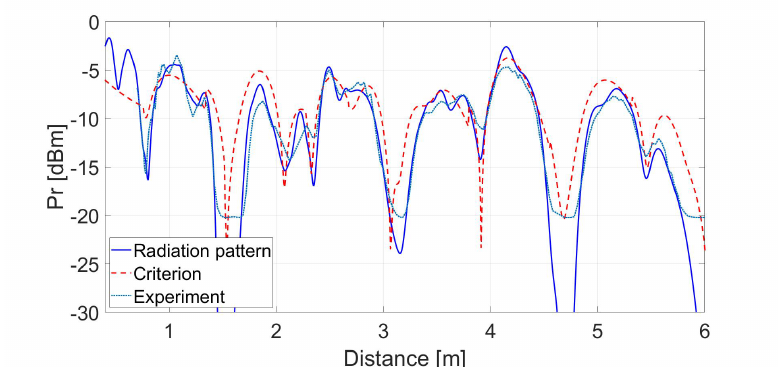
Figure 13. Comparison of the simulation and experimental results for vertical polarization using a radiation pattern and the criterion Equation (15) for maximum reflected